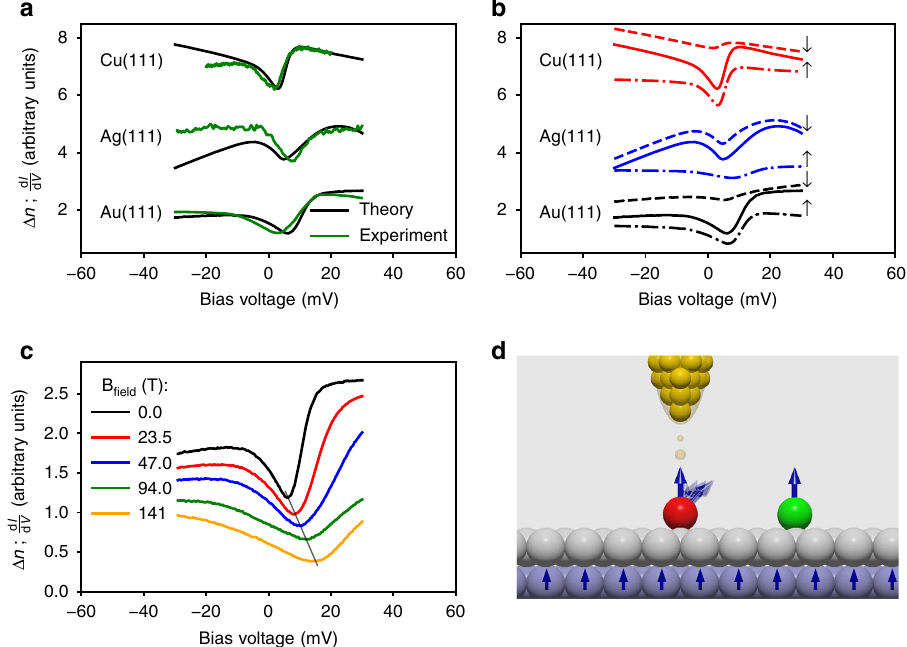
Fig. 3 Systematic tunneling transport spectra of Co adatoms on Cu, Ag and Au(111) surfaces. a Excellent agreement between the fi rst-principles spectra and those measured with STS at temperatures of 1.2 K 13 , 1.1 K 44 , 6 K 17 . b Spin-resolved spectra indicating that spin-polarized spectroscopy can reshape the measured differential conductance, which would help to disentangle the various contributions to the spectra. The total (solid) signal is obtained by the sum of both spin channels, which were shifted for a better visualization and comparison. c Response of the zero-bias anomalies to magnetic fi elds. The spin- excitation gap opens while the dip moves to larger energies. Large magnetic fi eld are possible in some STS setups (14 T 45 or even 38 T 46,47 ). d Proximity effects can be used via neighboring adatoms and by depositing thin fi lms of noble metals on a ferromagnetic substrate, where the magnetic exchange interaction felt by the adatom acts as an effective magnetic fi eld. The experimental data in a adapted with permission from IOP Publishing for Cu 13 and from the Japan Society of Applied Physics — Copyright (2005) for Au 17 as well as from Nature Publishing Group for Ag 44